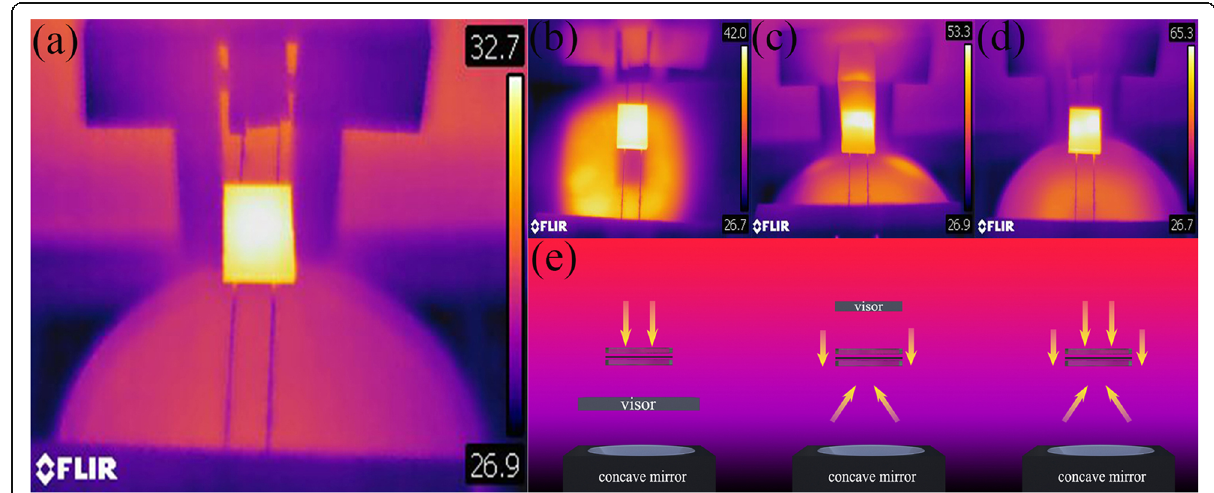
Fig. 4 Infrared photographs of different lighting conditions: a without light, b parallel light on the upper side, c concentrated light from the parabolic reflector, d light from both sides shines simultaneously, and e simulation diagram of different lighting conditions